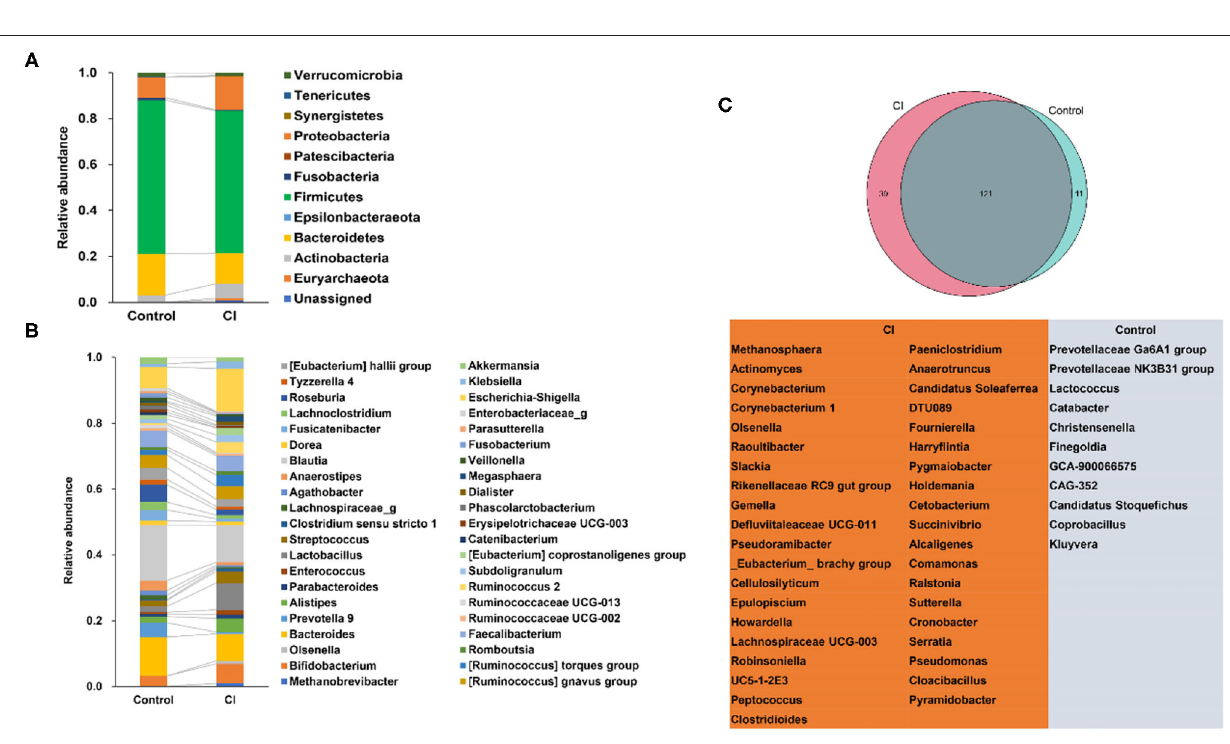
enriched in the control group ( Figure 4A ).